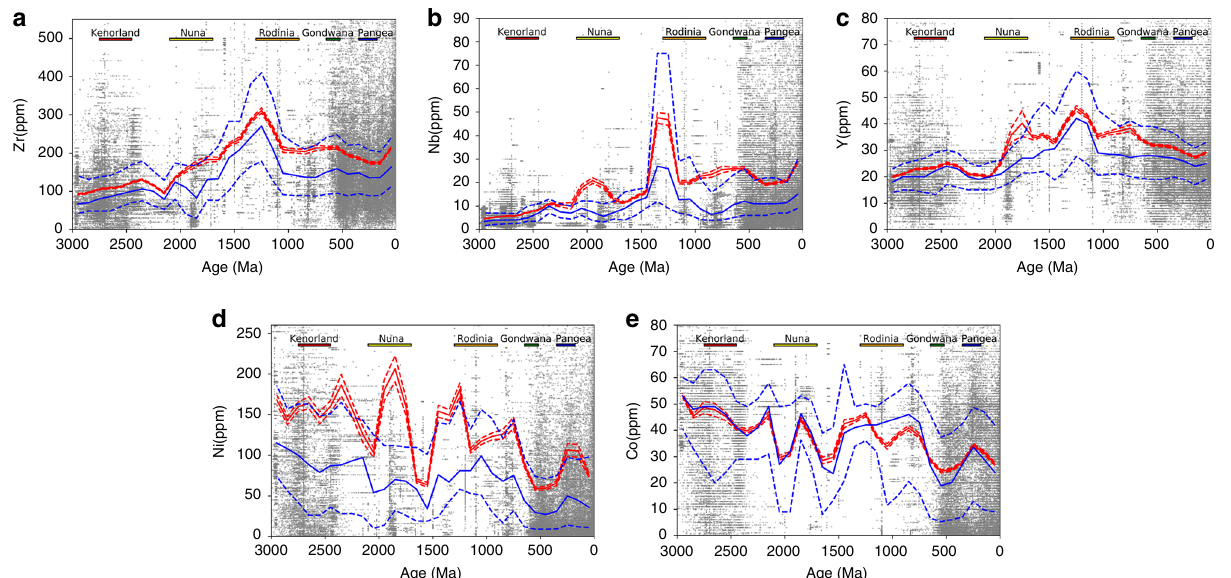
Fig. 2 Trace element concentration. ( a , Zr; b , Nb; c , Y; d , Ni; and e , Co) in global igneous rocks through the last 3.0 Ga. Zr, Nb, and Y exhibit the highest values during and immediately before Rodinian assembly, while Ni and Co show no depletions at the same time. The gray fi lled circles are data resampled from Earthchem with bootstrap resampling. Moving averages and medians of samples within ± 100 Ma bin size are calculated for each 100 Ma. Red solid line: average; Red dashed lines: 95% con fi dence interval of the moving average; Blue solid line: median; Blue dashed lines: the lower (25%) and